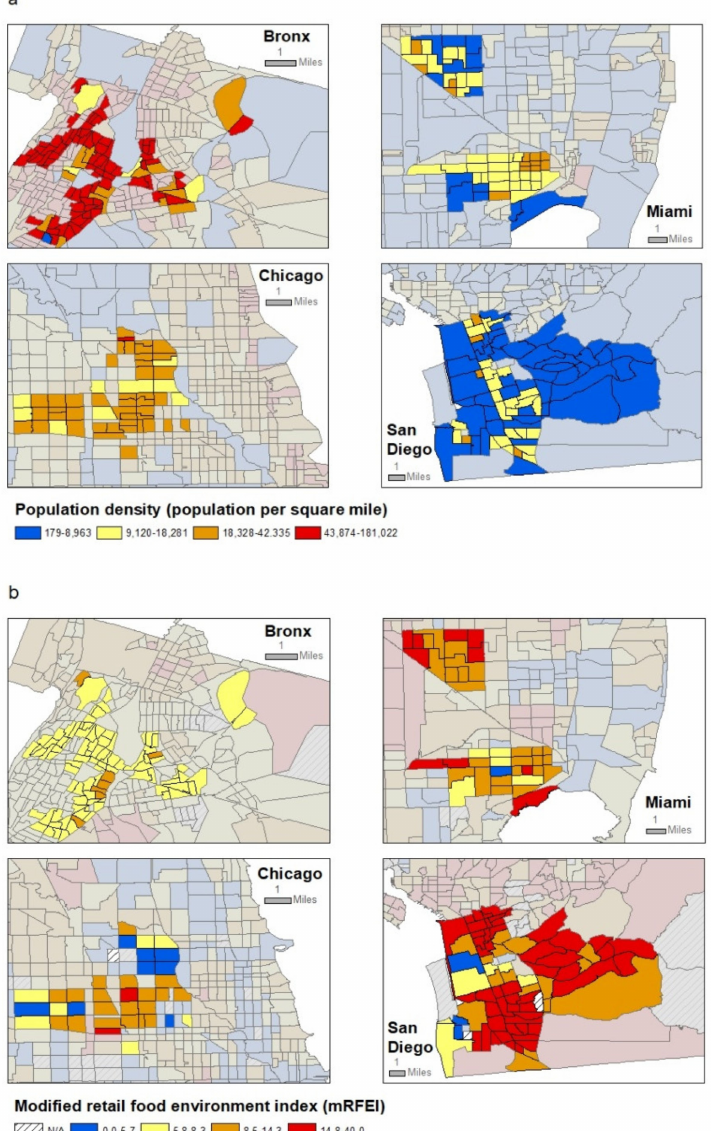
Figure 1. Population density ( a ) and modified retail food environment index ( b ) for residential census tracts of HCHS/SOL